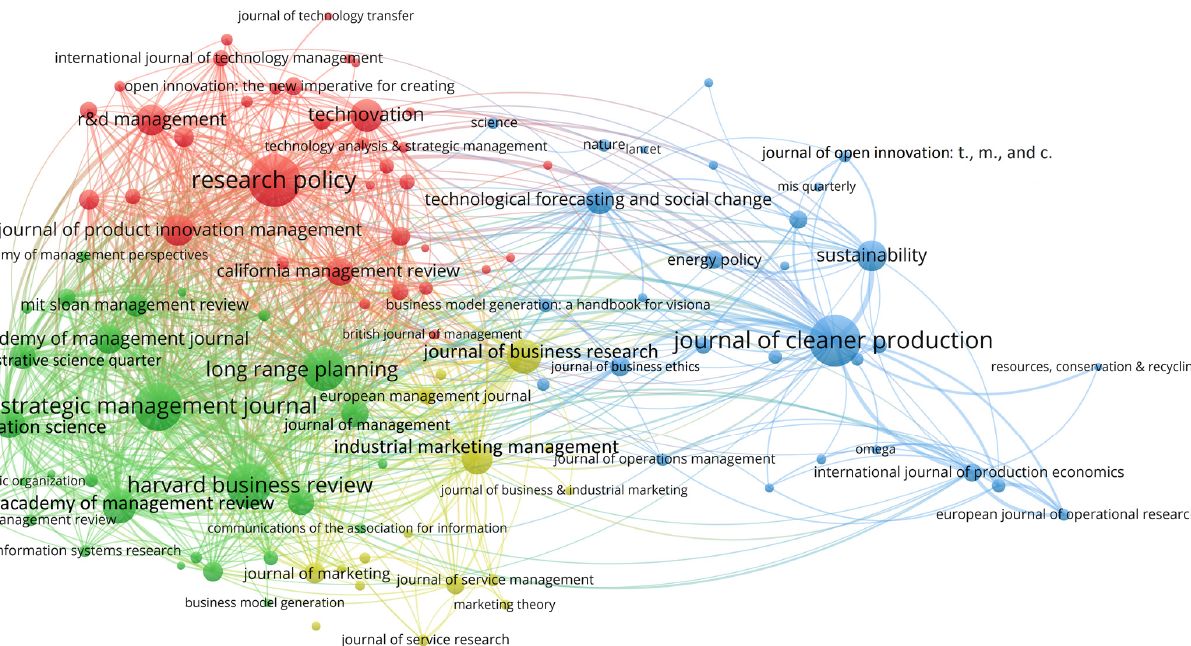
Figure 10. Co-citation network of sources in the BM&OI literature.